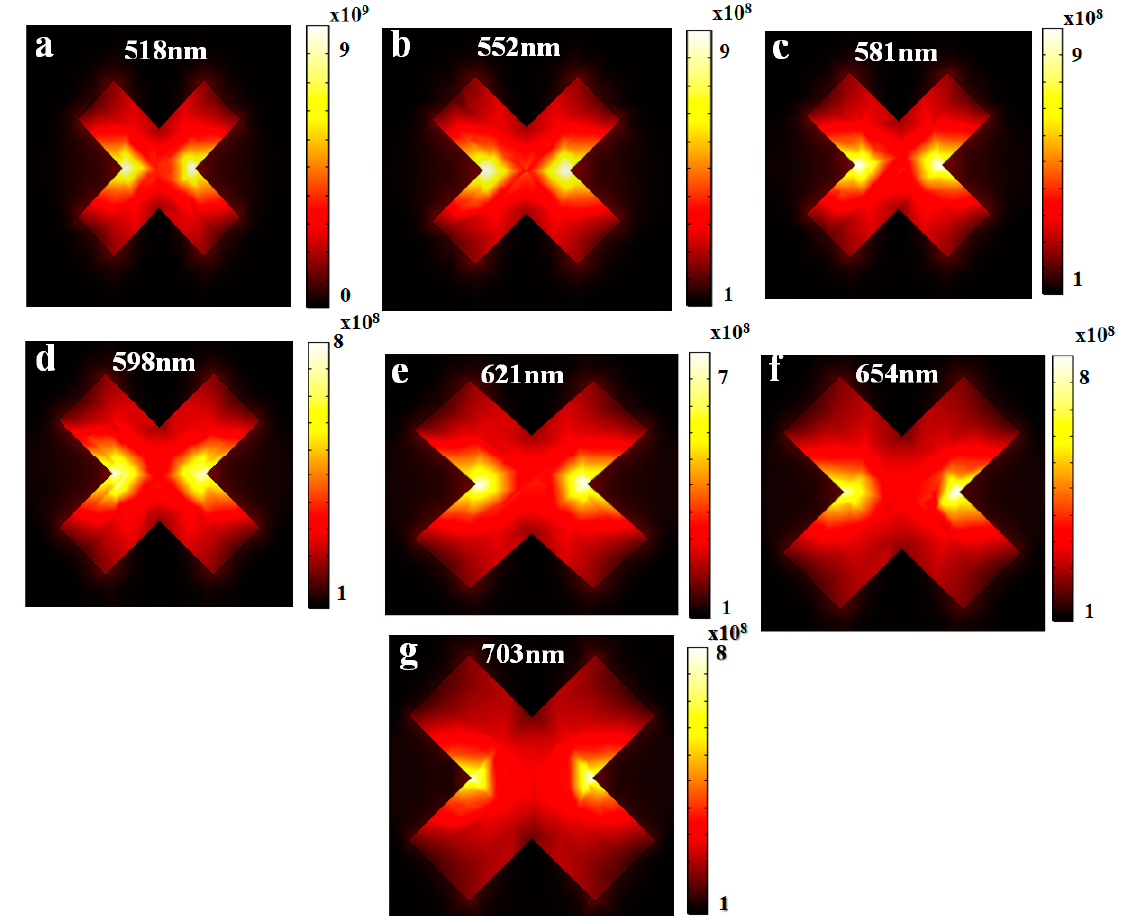
Figure 6. Electric field distribution for 7 EOT PCFs at wavelengths 518 nm ( a ), 552 nm ( b ), 581 nm ( c ), 598 nm ( d ), 621 nm ( e ), 654 nm ( f ), and 703 nm ( g ) by changing the width W1, W2 from 55 to 95 nm and length L1, L2 from 190 to 250 symmetrically.